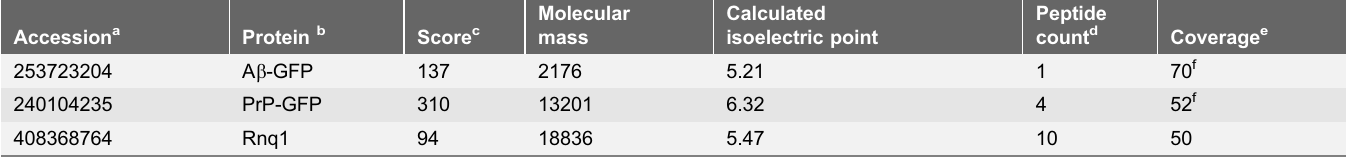
a GI number. b Standard protein names are indicated. c MASCOT protein score. d Number of unique peptides matched to mass peaks. e Sequence coverage in percent. f Percent of coverage without GFP sequence is indicated.